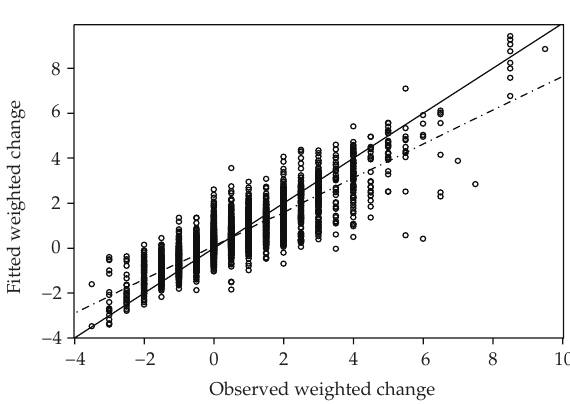
Figure 11: Plot of observed against fitted residuals in a random slope